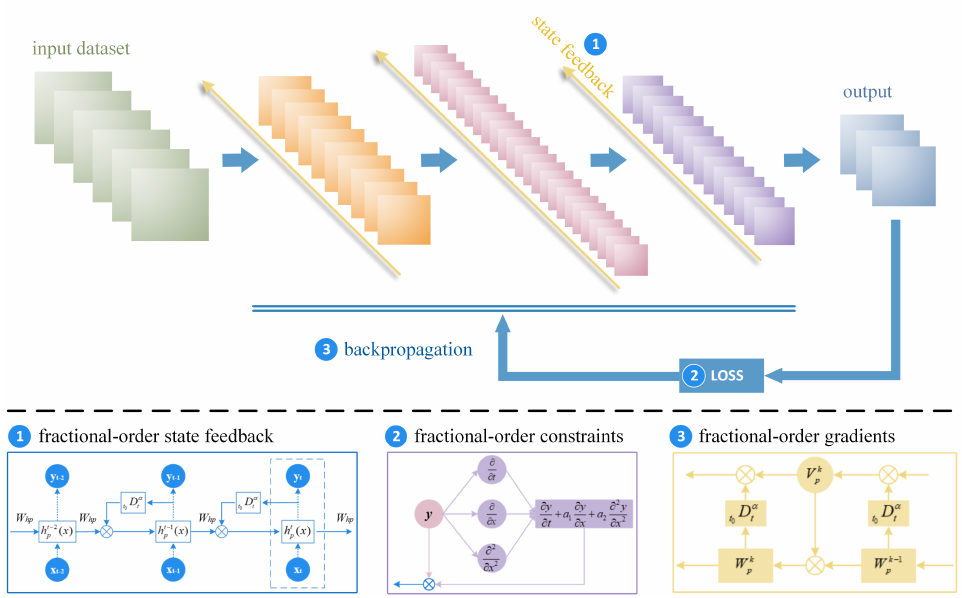
Figure 2. Fractional-order recurrent neural network encoding with physics-informed battery